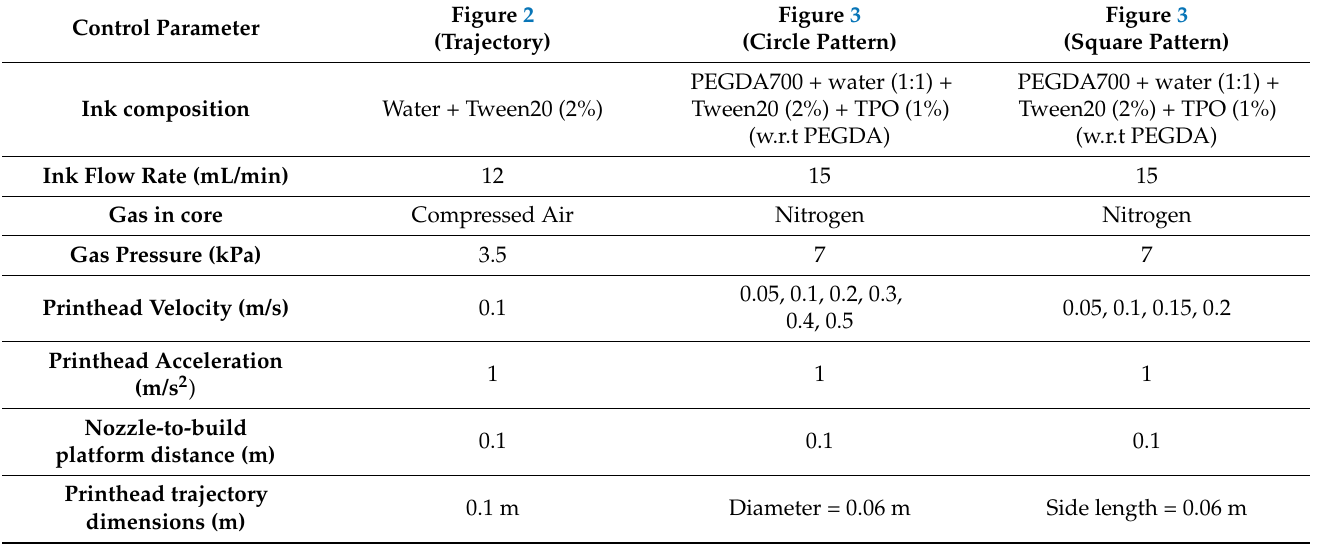
Table 1. Summary of the control parameter